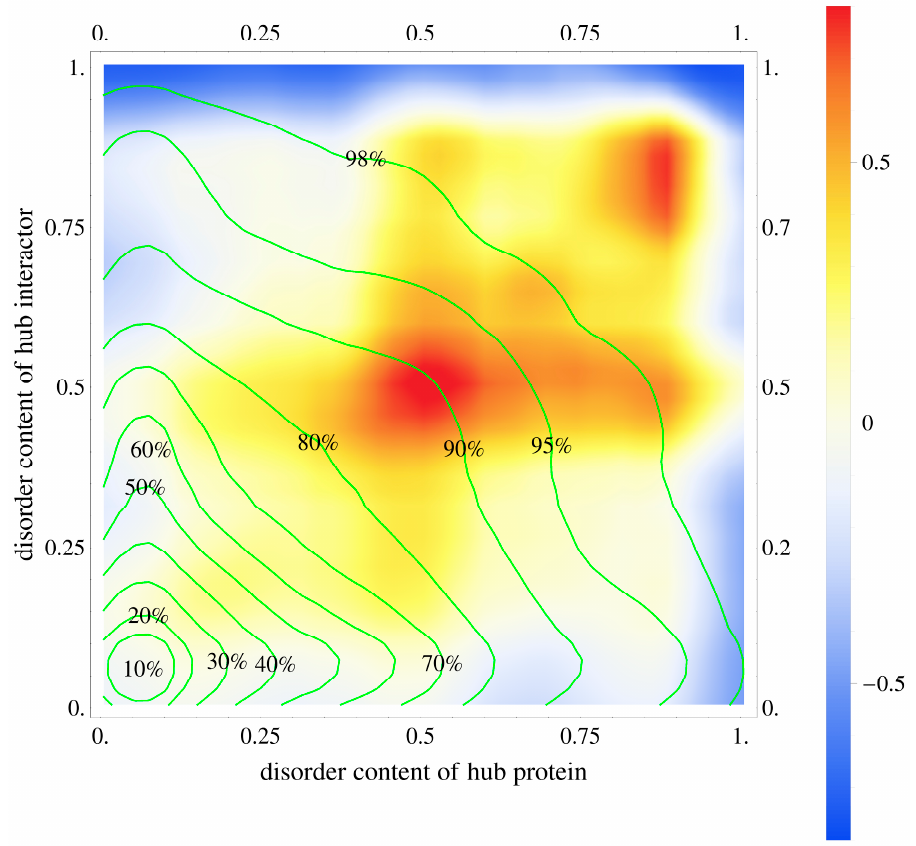
Figure 1. Enrichment in intrinsic disorder of human hub proteins and their interactors. The x - and y -axis show the amount of disorder content of the hubs and hub interactors, respectively. Each protein-protein interaction (PPI) is mapped into this two-dimensional plane and the density of these hub-interactor pairs is represented by green isolines. For instance, 40% of these pairs occupy the lower left corner where the disorder content of both hubs and interactors is below 0.25. The density was modelled with the Epanechnikov kernel function using Mathematica software. Next, we simulated a randomized PPI network that follows the same distribution of node density, i.e., we randomly assigned interactions between the human proteins to maintain the same density profile as in the true PPI network. Coloring of the inside of the two-dimensional plane reflects a relative ratio between the density of true ( d n ) and randomized ( d r ) interactions in the PPI networks calculated as [ d n (x,y)- d r (x,y)]/ d r (x,y). The color scale given on the right defines values of the ratio, e.g., orange corresponds to PPIs which are 0.5 times more frequent in the true PPI network compared to the random network.